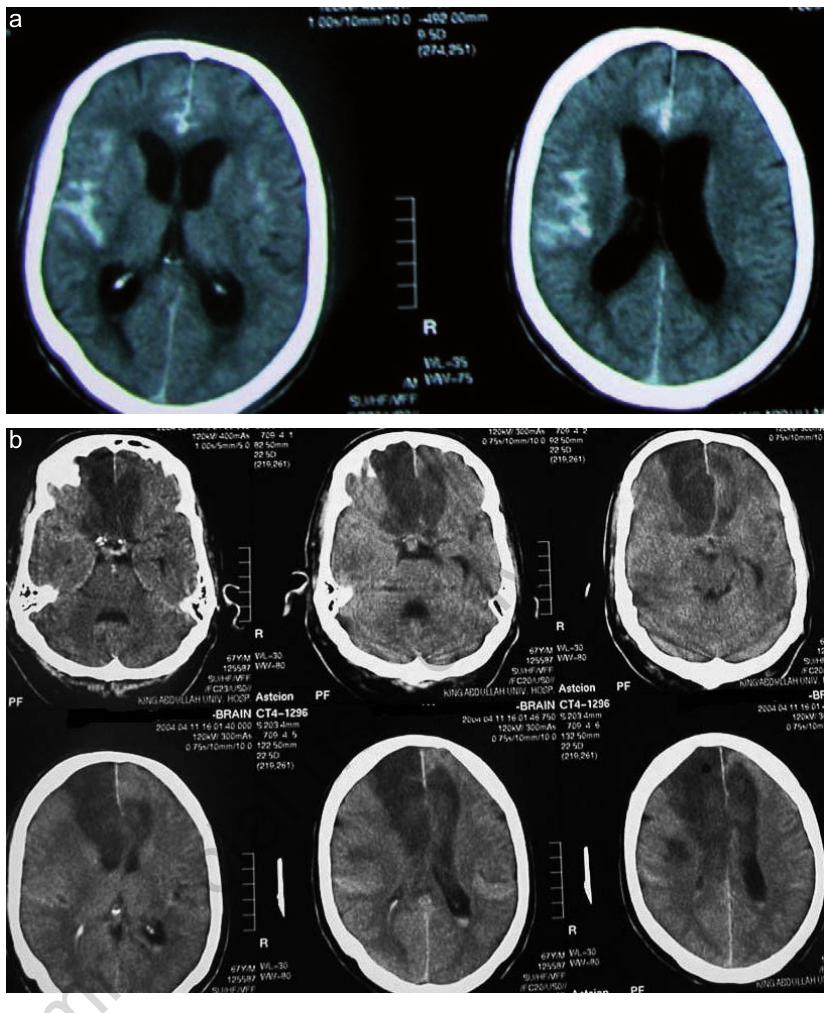
Figure 3. (a) CT scan of a 55 year-old man showing a large amount of blood in the sub- arachnoid space (Fisher grade 3). (b) CT scan of the same patient revealed bifrontal